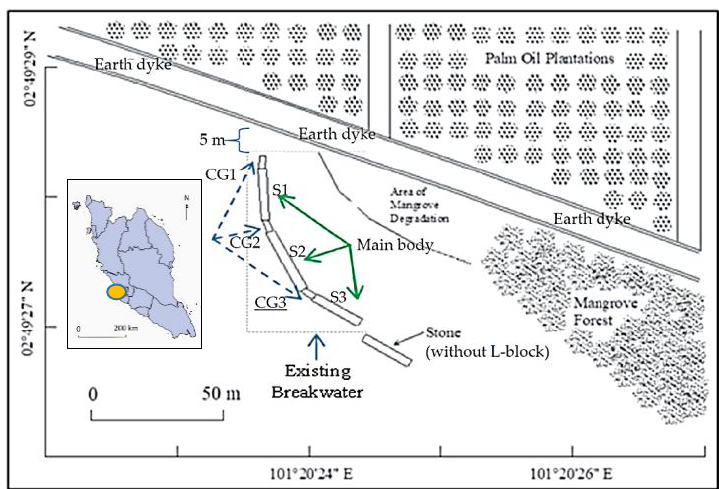
Figure 6. Low crested breakwater for sediment trap in Pulau Carey [81]. ‘Reprinted from Dynamics of sediment transport and erosion-deposition patterns in the locality of a detached low-crested breakwater on a cohesive coast, 2019; open access publication by MDPI